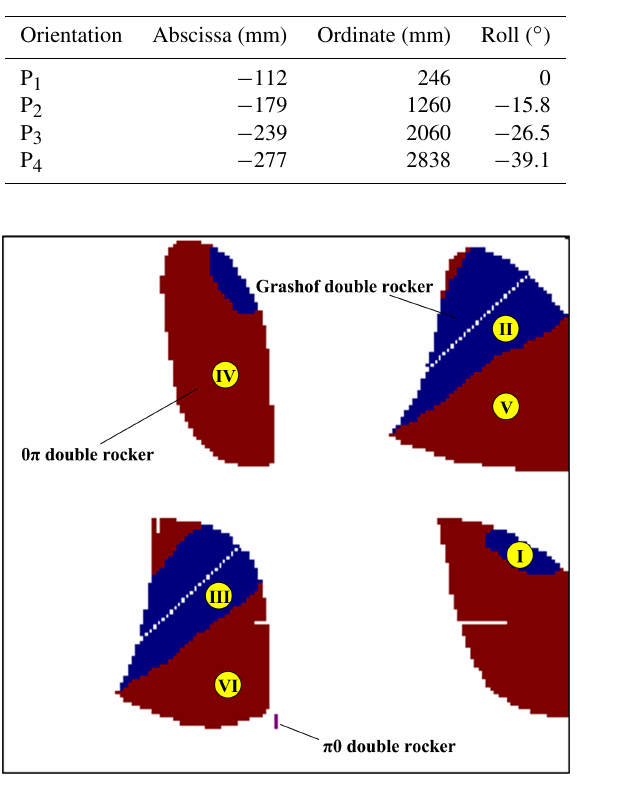
Table 4. Specified coupler orientations for a planar 4R linkage.